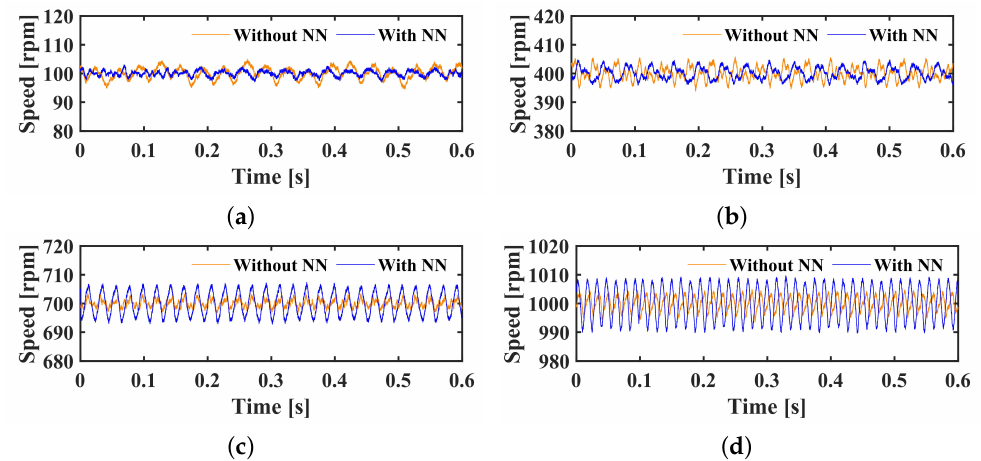
Figure 8. Speed ripple in conventional ESO-ADRC system and NN-ESO-ADRC system at the speed of: ( a ) 100 rpm, ( b ) 400 rpm, ( c ) 700 rpm, and ( d ) 1000